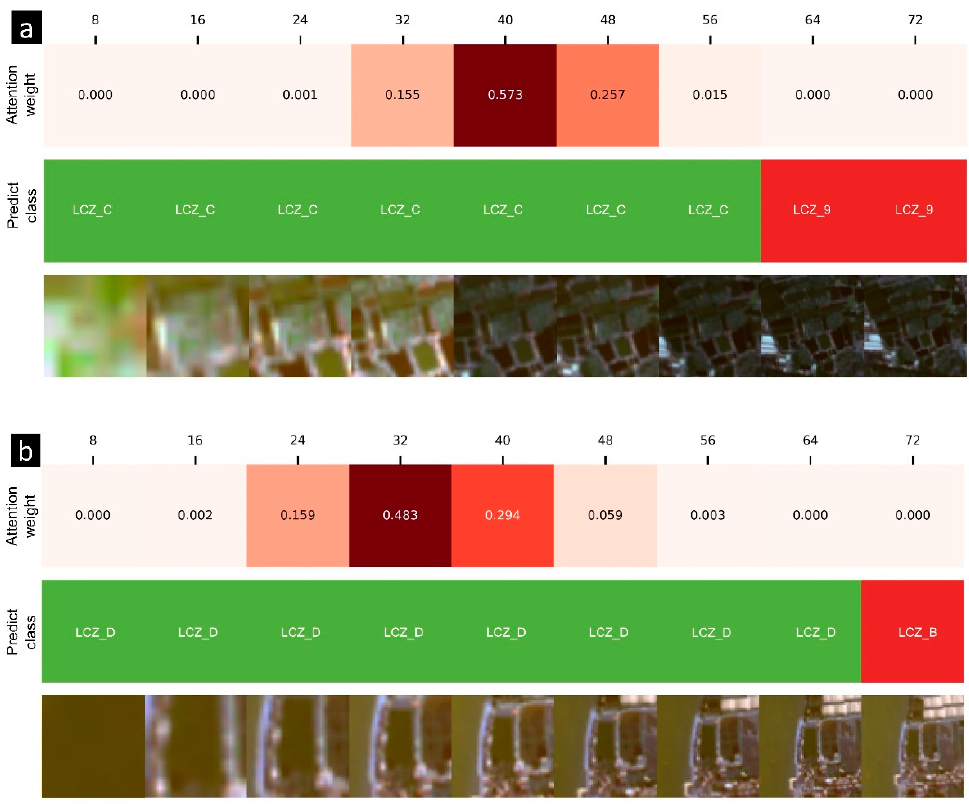
Figure 10. Samples of weighting sequential scenes. ( a ) LCZ-C and ( b ) LCZ-D. In each panel, from the first to the fourth row, they indicate the size, weight, type, and the original image of the patch, respectively.